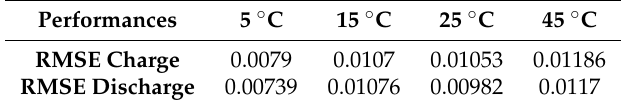
Table 8. Comparison of the OCV models’ precision at various temperatures. Performances 5 ◦